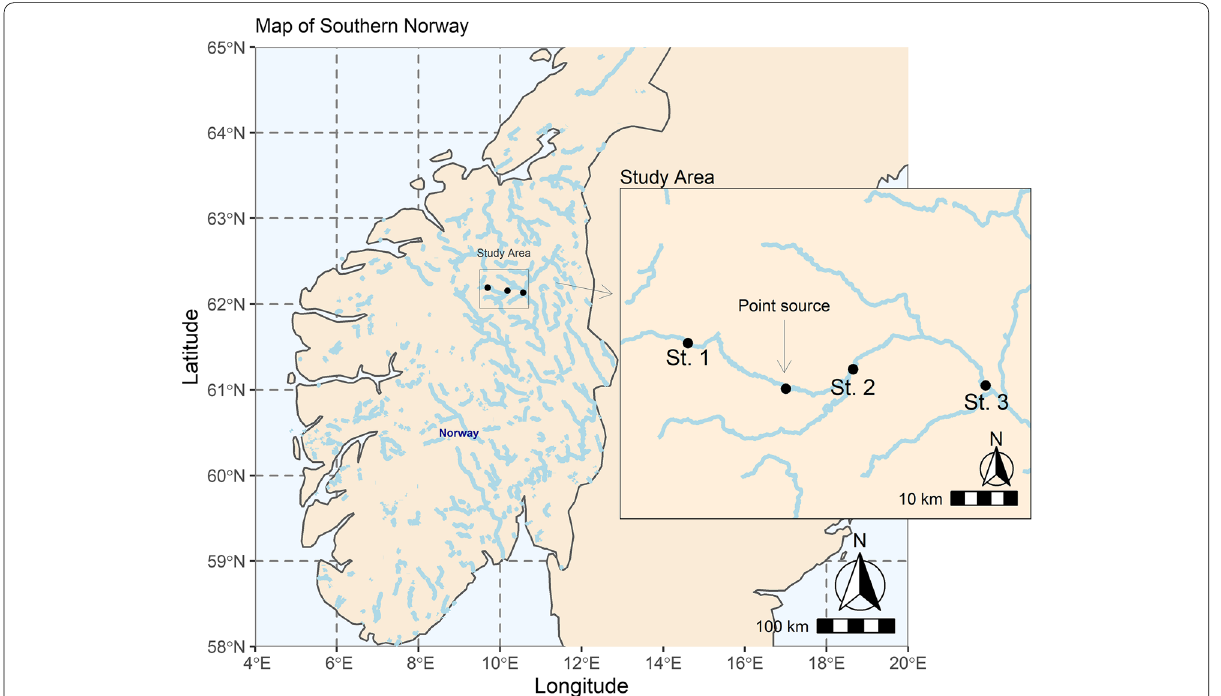
Fig. 1 Map of Southern Norway. The zoomed map shows sampling sites and the location of the point source of plastic